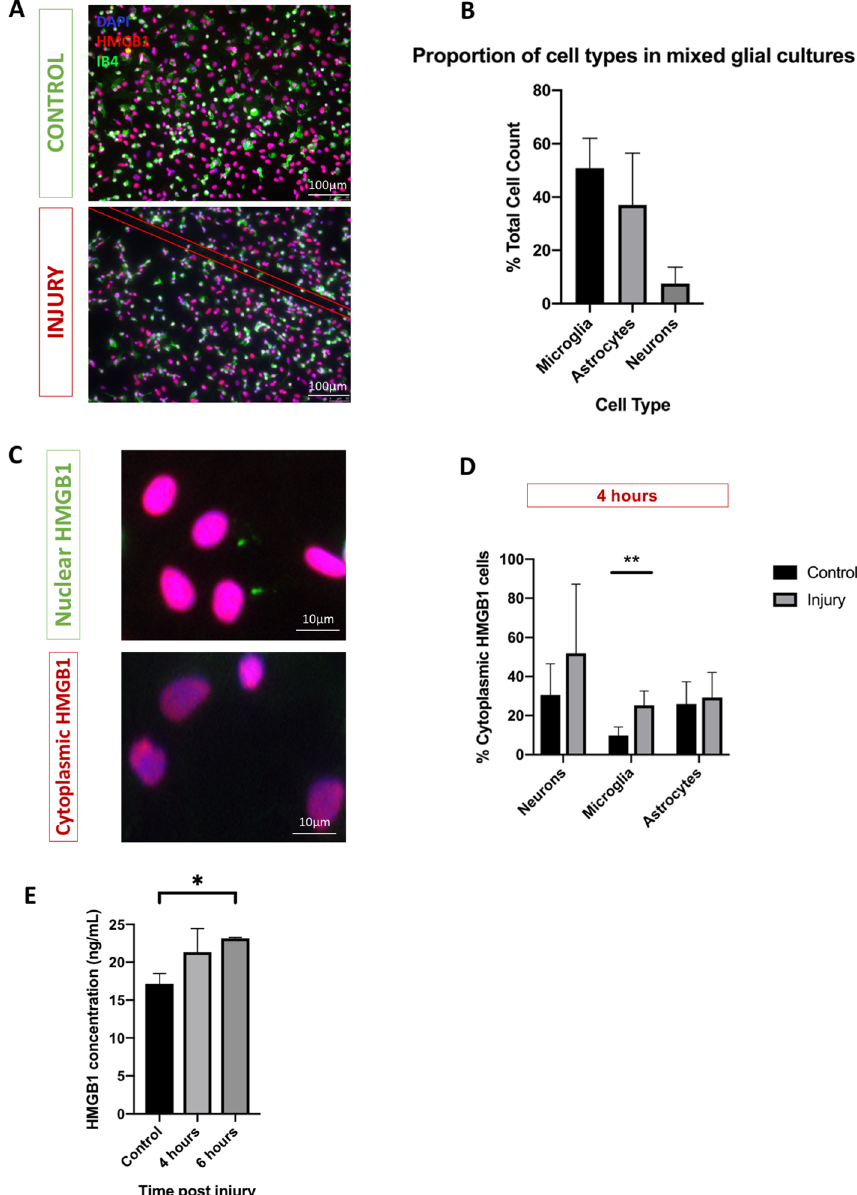
Figure 1. HMGB1 is released by microglia following injury. ( A ) Representative images of mixed neuro-glial cell cultures at 7 days in vitro: control (top panel) and scratch injury (bottom panel-site of injury indicated by red lines). ( B ) Mixed neuro-glial cell cultures consisted of microglia (IB4 + cells), astrocytes (GFAP + cells), and neurons (Tuj1 + cells). ( C ) Representative images for nuclear (top panel) and cytoplasmic pattern (bottom panel) of HMGB1 staining (Red). ( D ) Demonstrates a hyperacute increase in the proportion of microglial (IB4 + ) cells with nuclear-cytoplasmic HMGB1 translocation at 4hrs post injury with relative to control. This did not reach statistical significance in Tuj1 + or GFAP + cells. ( E ) ELISA assays revealed significant increases in extracellular HMGB1 concentration at 6 h post-injury. Data represent mean ± standard error based on a sample that represents at least 10 wells per condition from three different experiments. For comparisons between two conditions, two-tailed student’s T-test was used, and for multiple different conditions, a two ‐ way ANOVA and one-way ANOVA with Dunnett’s multiple comparison test was used. p values of < 0.05 were considered significant (* p < 0.05; ** p < 0.01; *** p < 0.001; **** p < 0.0001). cNSPCs = rat cortical neural stem cell progenitors; DIV = days in